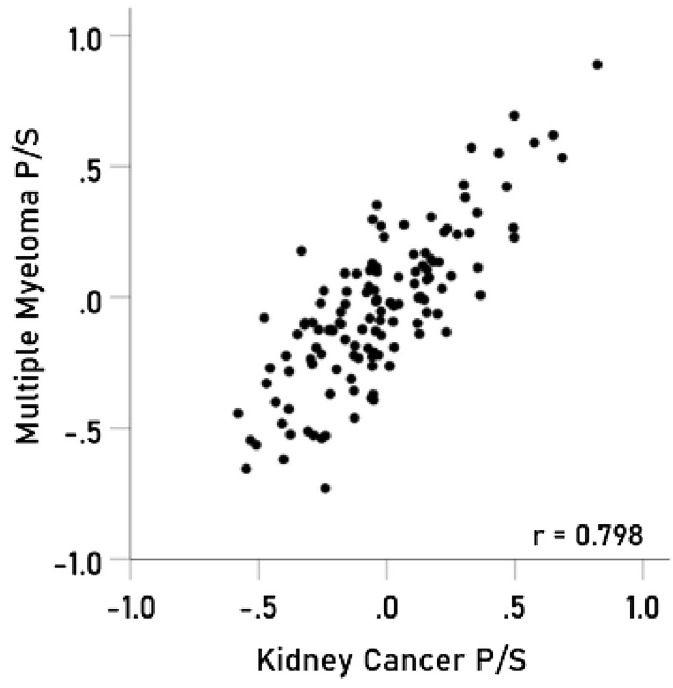
Figure 2. Immunogenetic P/S estimates for multiple myeloma are plotted against those for kidney cancer. r is the Pearson correlation coefficient; P < 0.001; N = 127.